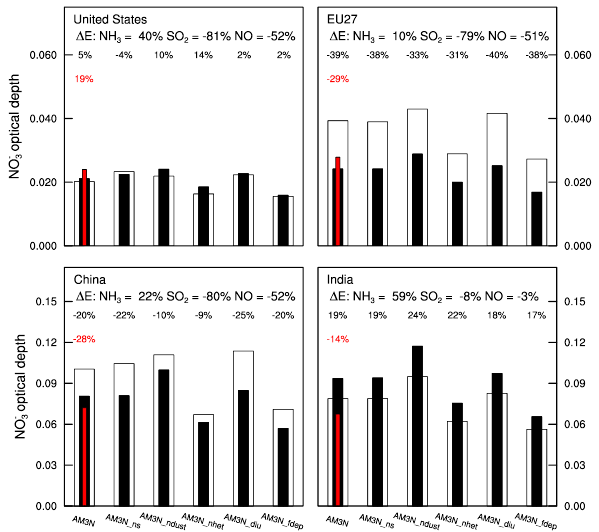
Figure 11. Nitrate optical depth at 550nm over the United States, Europe, China, and India for 2008–2010 (white bars) and 2050 (black bars) anthropogenic emissions for different configurations of AM3N. The thin red bar indicates the nitrate optical depth calcu- lated using RCP8.5 2050 NH 3 emissions in AM3N. The relative changes between 2008–2010 and 2050 in NO − surface emissions of NH 3 , SO 2 , and NO are indicated for each re-